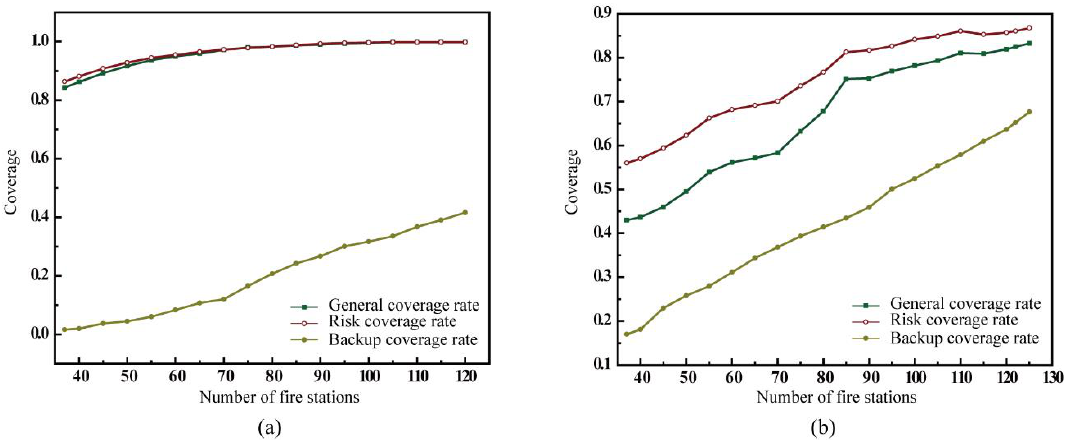
Figure 11. Number of facilities and coverage rate. ( a ) Performance in maximal coverage model (MCM); ( b ) performance in backup coverage model (BCM). (MCM); ( b ) performance in backup coverage model